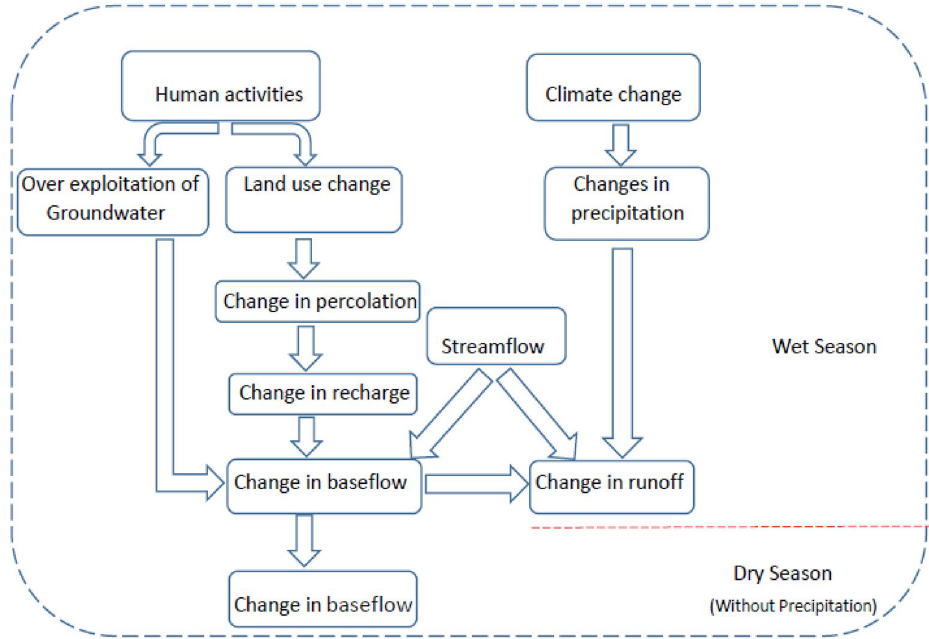
Figure 2. Conceptual relationship between human activity and changing climate impact in the Semiarid